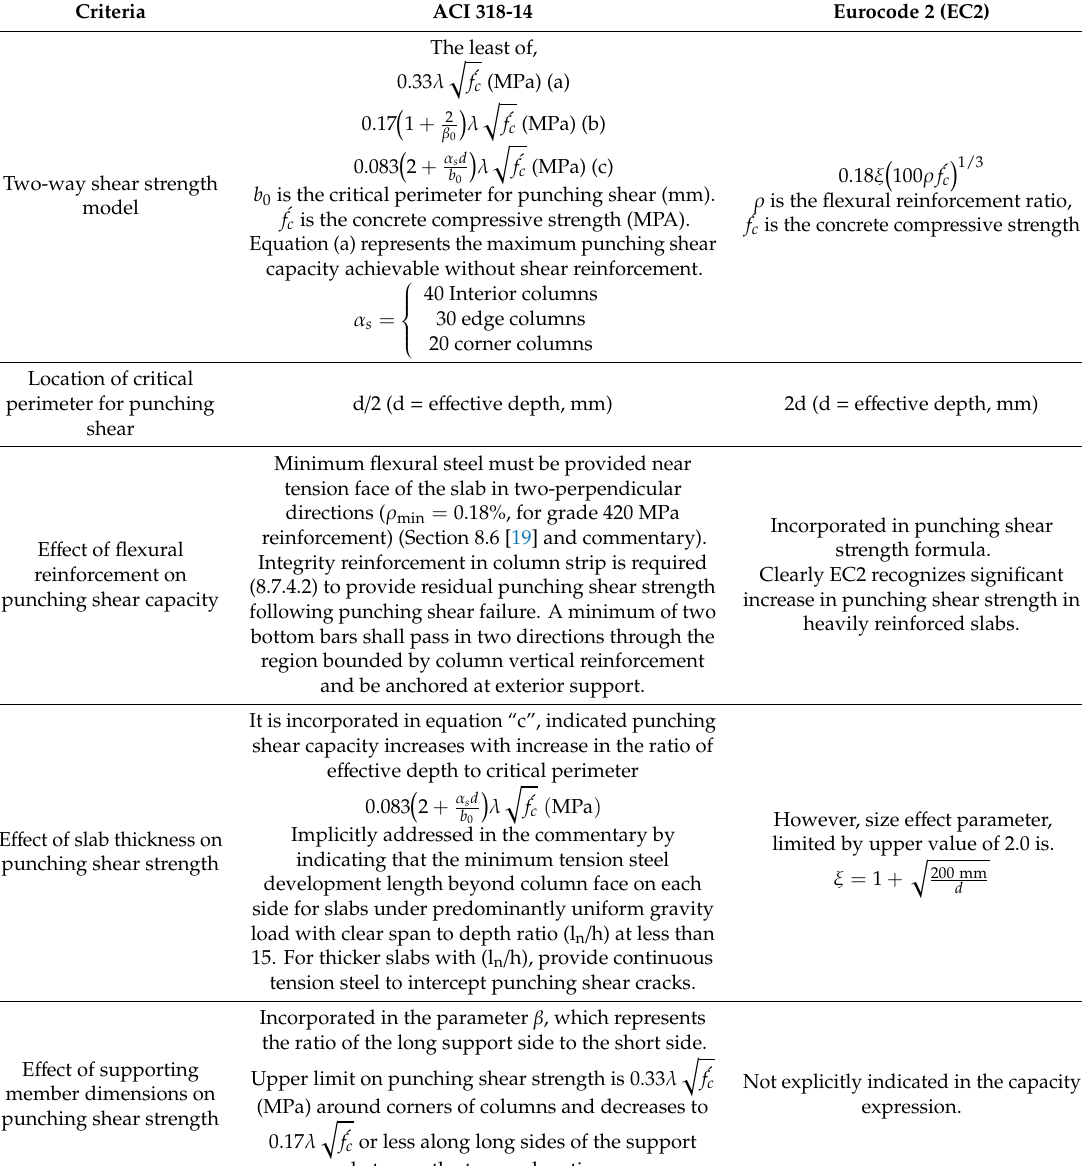
Table 1. Comparison of two-way shear capacity in American Concrete Institute code ACI 318 and Eurocode 2 (EC